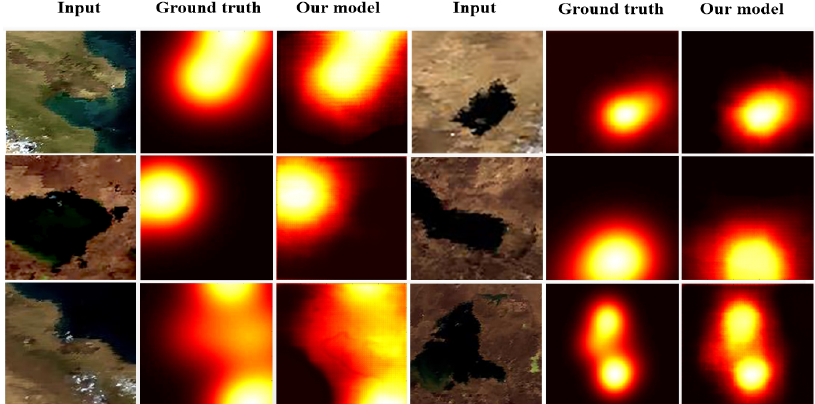
Figure 7. The mapping result of the selected samples in the test dataset. In each set, the first image is the true color composite (band 1,4,3) of MODIS land products, which represents the input remote sensing imagery. The last image (ground truth) is estimated by the kernel UD estimator with GPS data. The middle one is the synthesized home range map which is directly mapped from remote sensing images using our end-to-end model. We colorized the original probability map with the hot